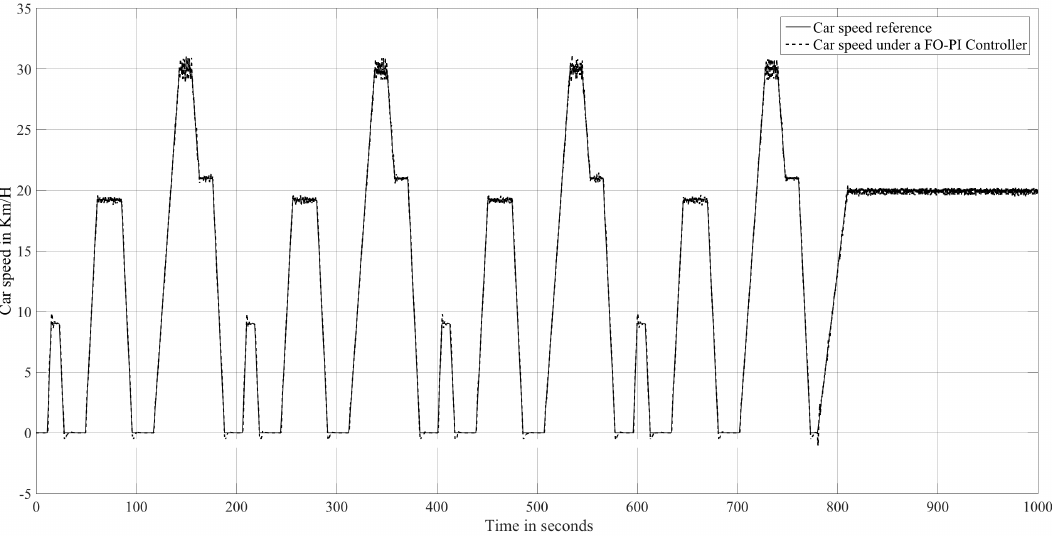
Figure 13. Car speed with the system under a fractional order PI controller.